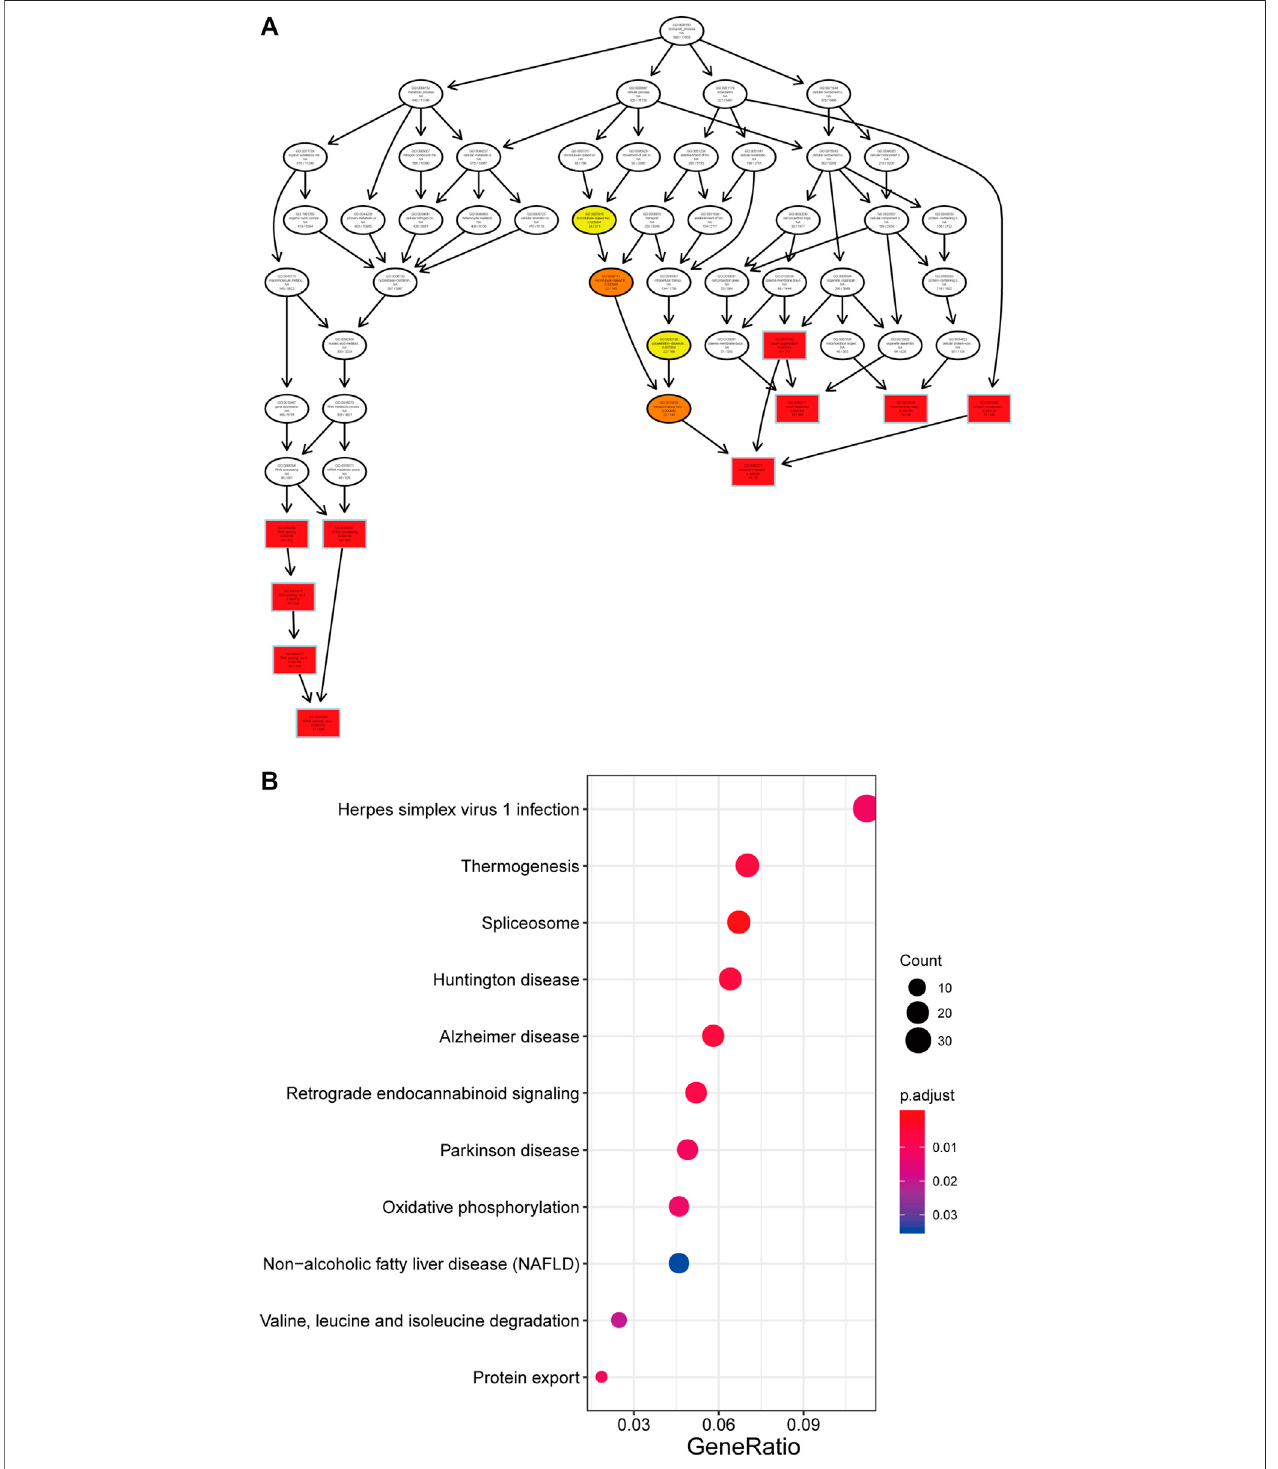
FIGURE 6 | Function of the three lncRNA for GO (A) and KEGG (B) analysis by clusterPro fi ler.